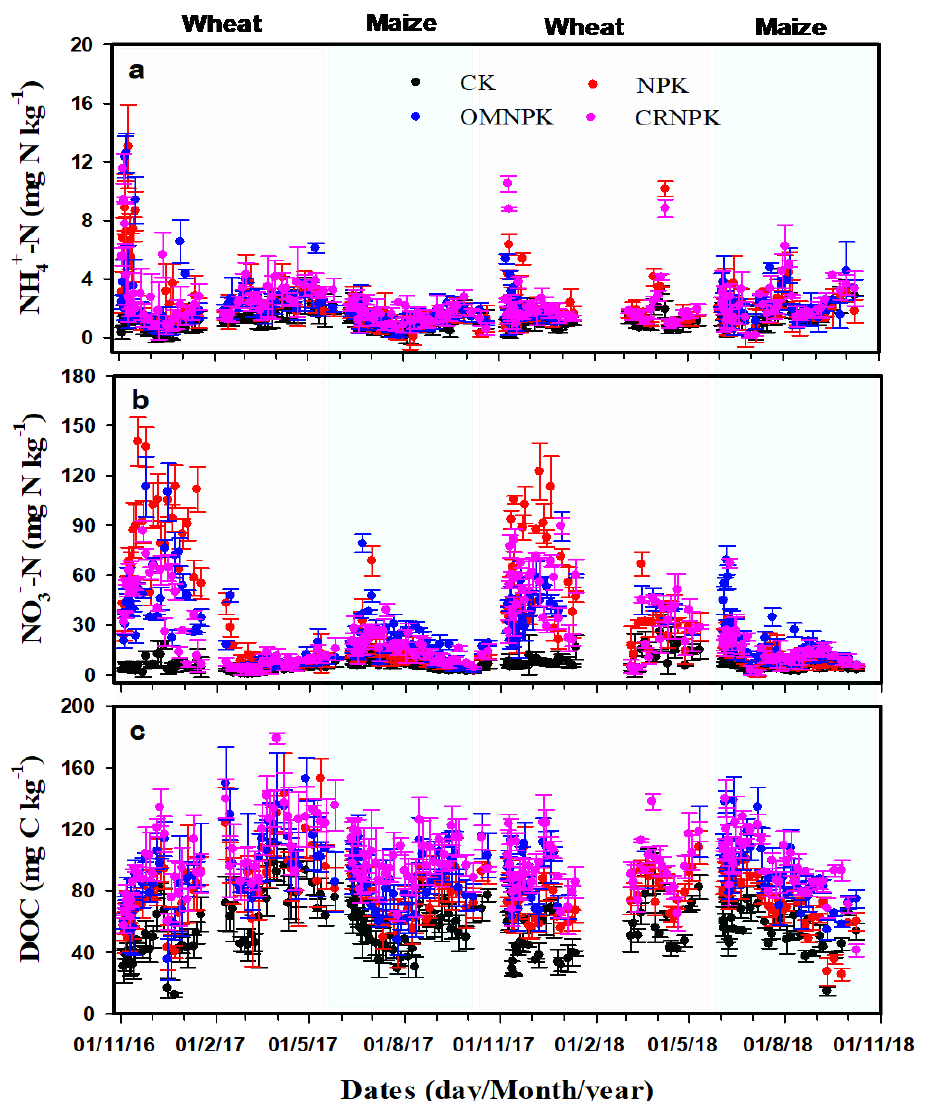
Figure 5. Seasonal variations of soil ammonia nitrogen (NH 4+ -N) ( a ), soil nitrate nitrogen (NO 3 − -N) ( b ), and dissolved organic carbon (DOC) ( c ) contents of topsoil (0–15 cm) of wheat-maize rotations for the four treatments over the two-year period from 2016 – 2018. The vertical bars indicate the standard errors of spatial replicates ( n = 3).